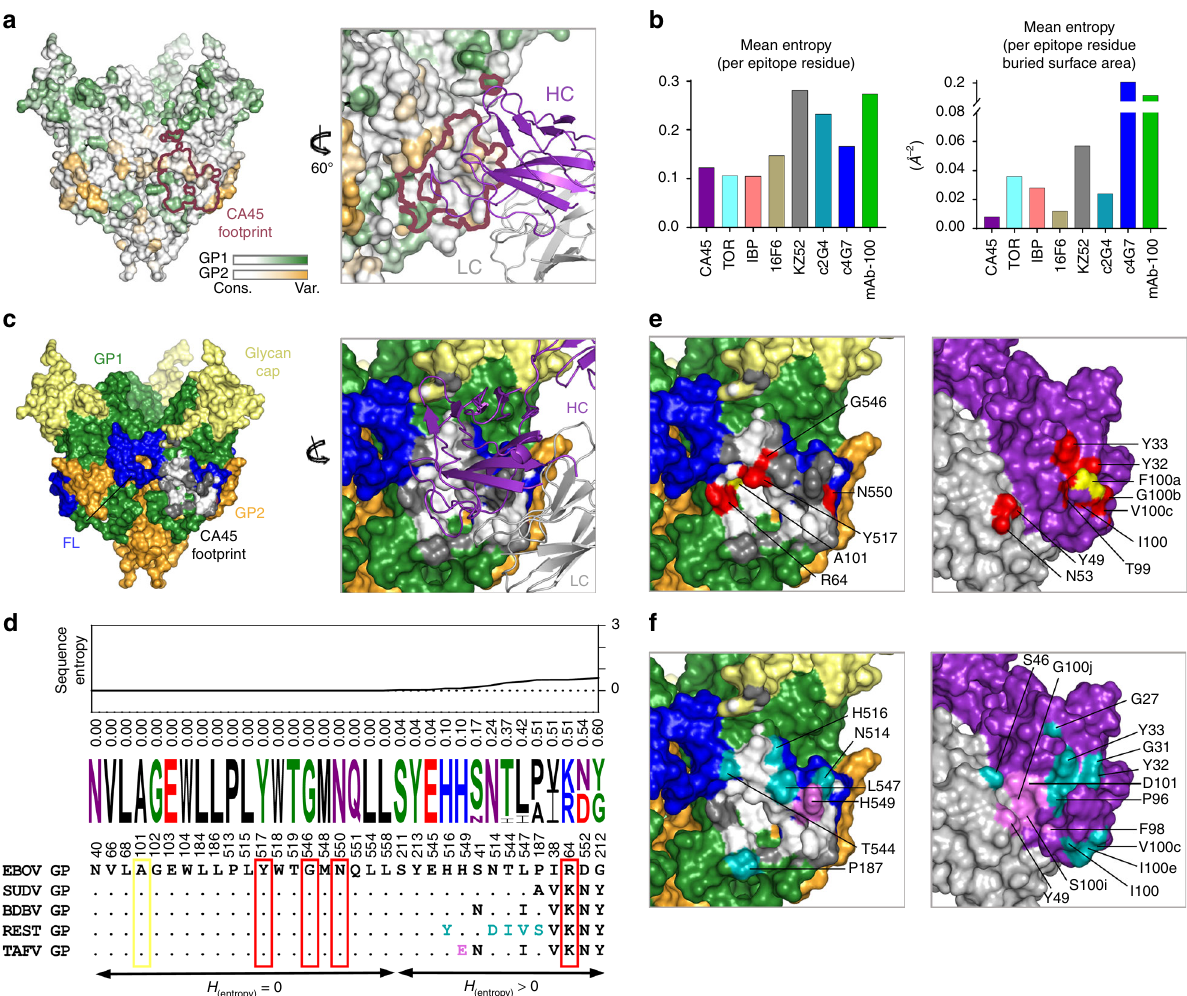
Fig. 3 Structural basis for broad ebolavirus neutralization by antibody CA45. a Surface representation of CA45-bound EBOV GP Δ Muc trimer (left) colored by Shannon sequence entropy on a scale of increasing entropy from white to green (GP1) and white to orange (GP2), with border of CA45 footprint colored raspberry. Close-up view rotated by 60° (right), with bound CA45 heavy and light chains shown in purple and gray, respectively. b Comparison of mean entropies of CA45 epitope with those of other neutralizing antibodies and inhibitors that target the GP1 – GP2 interface, by mean entropy per GP-binding site residue (left) or normalized by individual residue buried surface area (right). c Surface representation of CA45-bound EBOV GP Δ Muc trimer (left), colored by subunit and subdomain, with CA45 epitope residues conserved in > 99.5% of ebolavirus isolates colored white and variable residues colored dark gray. Close-up and rotated view of CA45 epitope with bound antibody shown as colored in a . d Sequence alignment of CA45 epitope residues across representative ebolavirus sequences. Residues are listed in order of increasing sequence entropy, with entropy values listed and graphed above. Sequence logo re fl ects sequence variation across representative ebolavirus sequences from previous outbreaks 38 , with residues colored by amino acid type. CA45- speci fi c alanine sensitive mutations and escape mutation are boxed in red and yellow, respectively. Residues unique in RESTV and TAFV colored teal and violet, respectively. e “ Open-book ” view of right panel in c with surface representation of antibody shown rotated by 180° relative to view in c . Alanine sensitive mutations and escape mutation mapped onto surface of GP in red and yellow respectively (left), with corresponding interface residues on antibody colored similarly (right). f “ Open-book ” view of right panel in c , with residue positions unique to RESTV and TAFV mapped onto surface of GP in teal and violet, respectively, with corresponding interface residues on antibody colored similarly